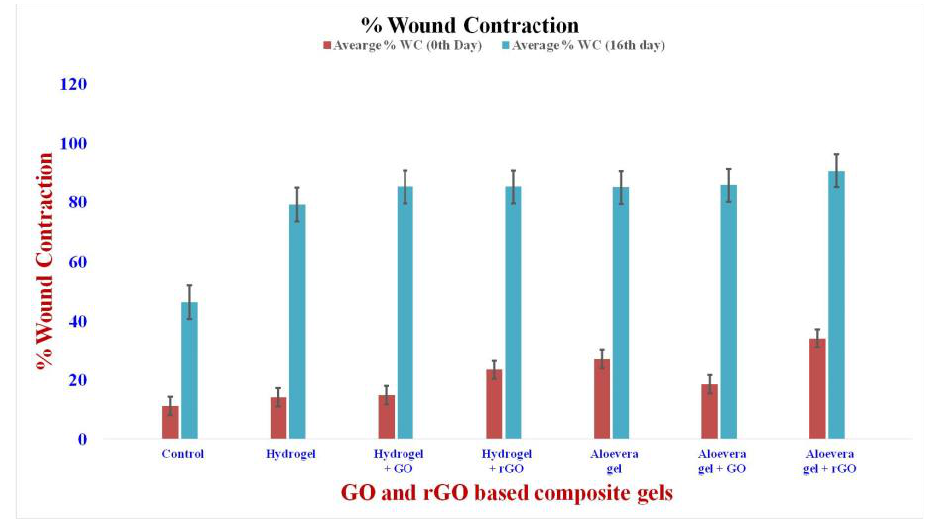
Figure 16. In vivo wound contraction of GO and rGO-based composite gels.